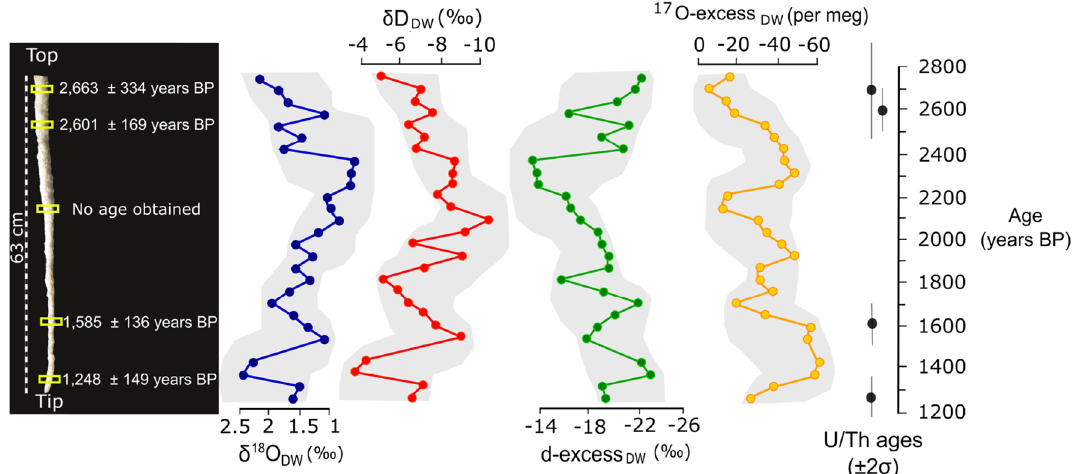
Figure 2. U–Th ages of the SBL stalactite (see Supplementary Table S1 online for details) and triple oxygen and hydrogen isotope reconstruction of speleothem-forming water in Sima Blanca cave. The isotopic composition of evaporated paleo-dripwater (DW) are obtained from GHW (Supplementary Table S2 online) using the fractionation factors between free water and GHW 8,9 . The grey shades represent the time-series 95% confidence interval of the proxies obtained from COPRA 21 which combines analytical and chronological